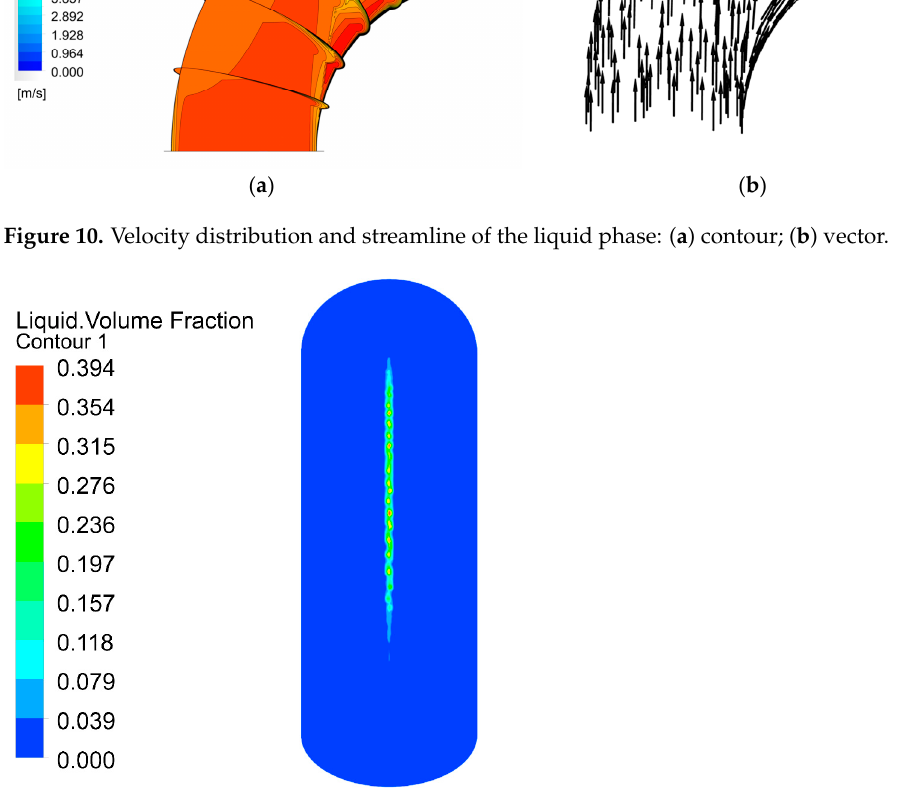
Figure 11. Distribution of the volume fraction of the liquid phase.